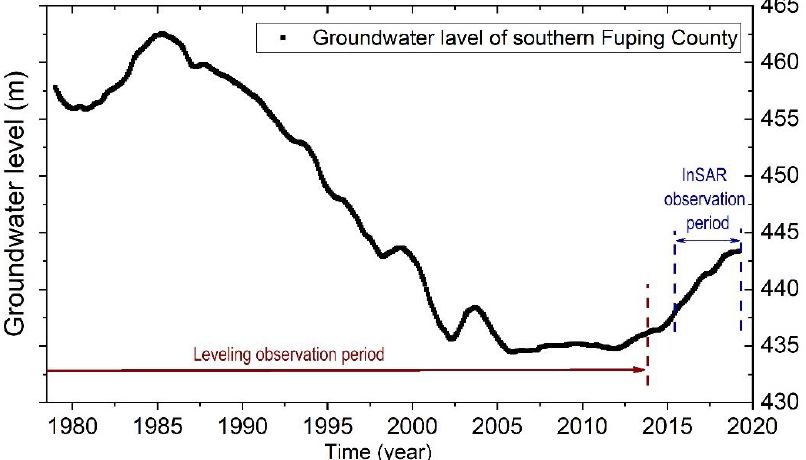
Figure 6. The average groundwater level in southern Fuping County (modified from Chai, 2021).